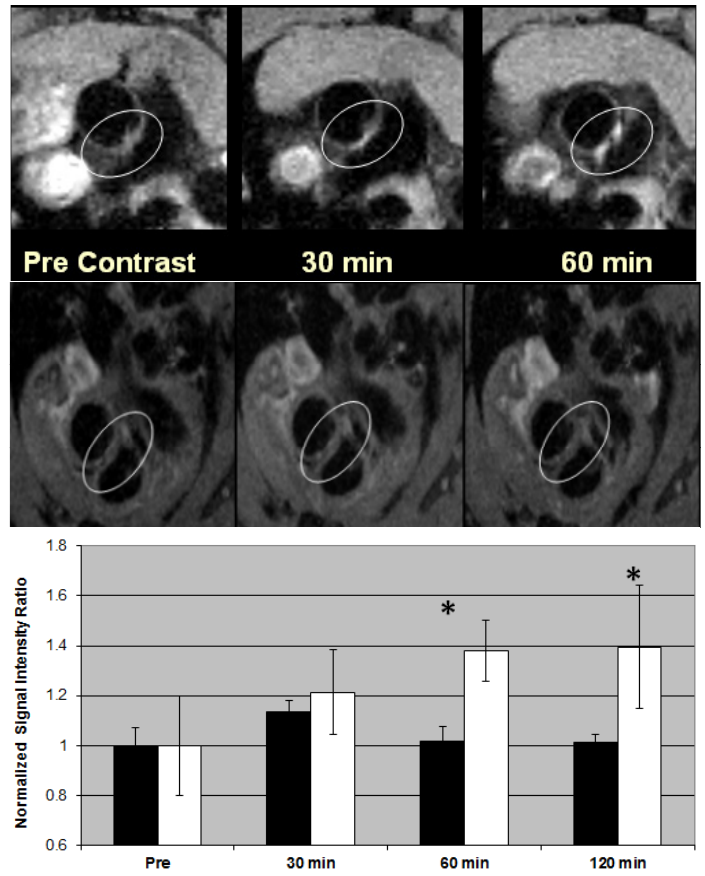
Figure 5. Figure: Plaque imaging of aorta arch of 23 weeks old female ApoE − / − mice with 7 T imager. Top : ATCA (100 µL, 4.0 mg/kg or 0.9 mg Gd/kg); Bottom : Non-targeted control did not enhance any contrast. Graph: Quantification of signal enhancement. The signal to noise ratio (SNR) was calculated using a reference ROI next to the plaque lesion, then SNR values were normalized to the pre-injection SNR value. The same regions were traced throughout all imaging points. ATCA: white bars, and non-targeted control: black bars. The SNR values are shown as mean for the entire aorta of five mice. * indicates significance ( p <